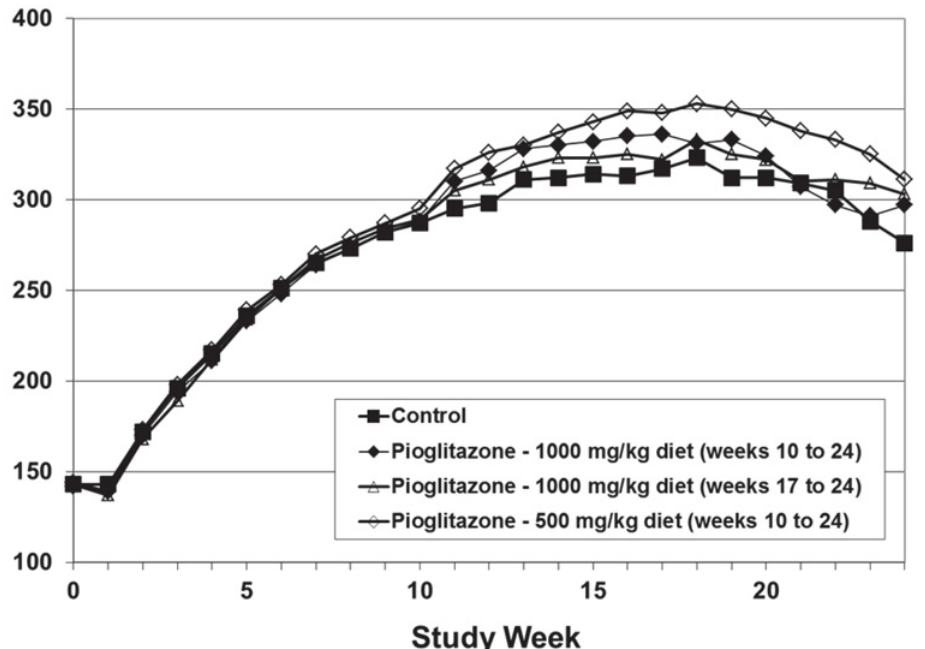
Fig 2. Influence of Pioglitazone on Group Mean Body Weight in NQO-Treated Rats. Pioglitazone was administered at 500 or 1000 mg/kg diet to NQO- treated rats beginning at week 10 (1 day after completion of NQO administration), or at 1000 mg/kg diet beginning at week 17 (7 weeks after completion of NQO administration; late administration group). In comparison to the NQO-treated control group, statistically significant increases in group mean body weight were seen in pioglitazone-treated rats at the following times: 500 mg pioglitazone per kg diet, weeks 12 through 21; 1000 mg pioglitazone per kg diet, week 12, 14, 15, and 16; 100 mg pioglitazone per kg diet (late), no statistically significant differences at any time point.